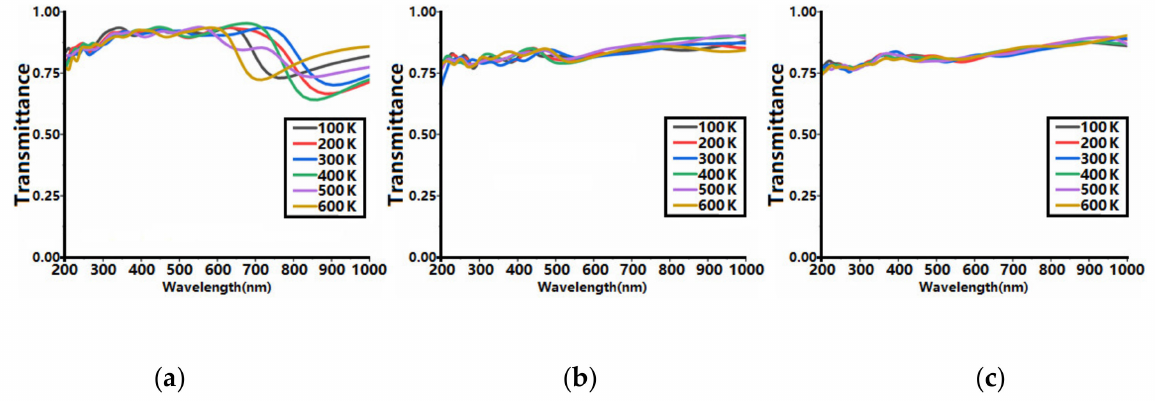
Figure 9. Transmittance spectra of 1 ( a ), 2 ( b ), and 3 nm ( c ) ITO models at temperatures ranging from 100 to 600 K.